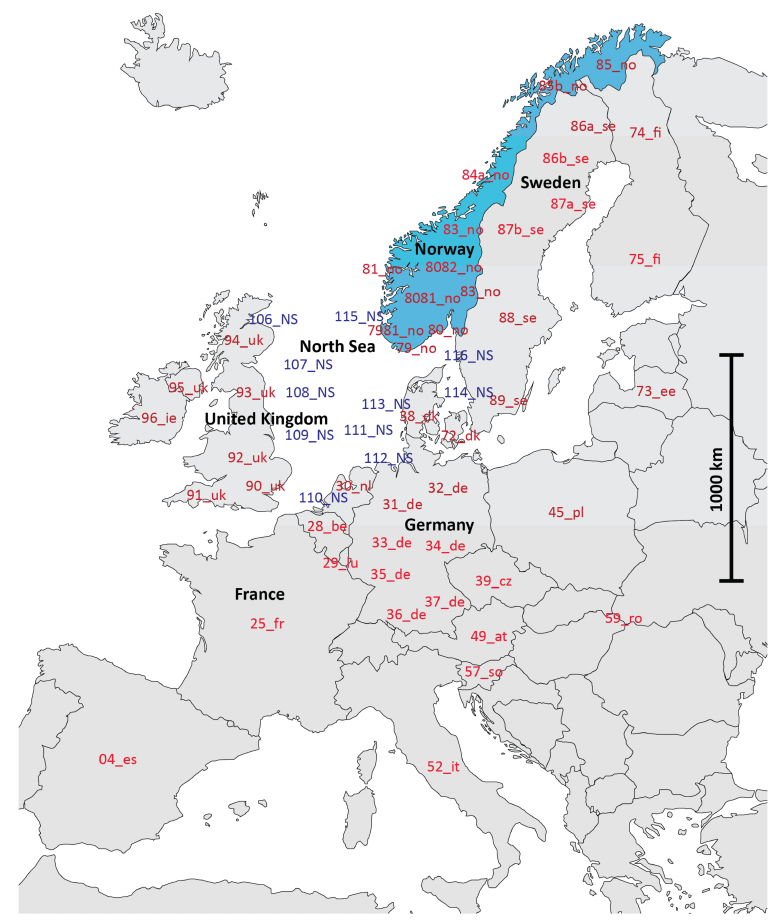
Figure 1. Nodes (regions) in the EFI’s (former name of SINTEF Energy Research) Multi-area Power Market Simulator (EMPS)